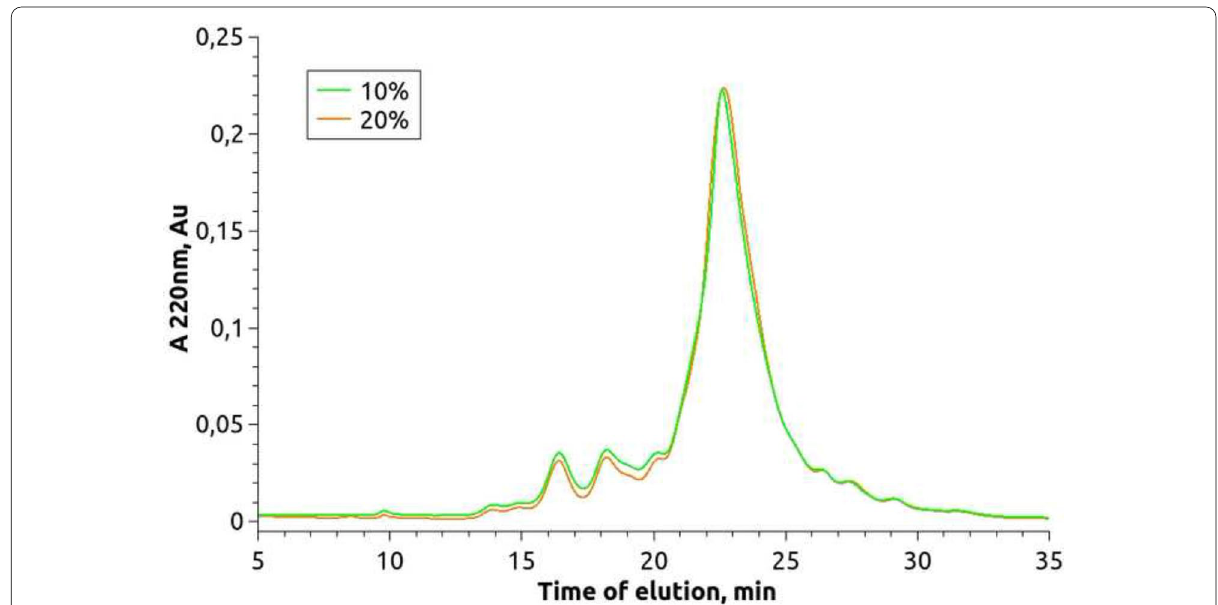
Fig. 5 Chromatogram of 10% and 20% SPI hydrolysate. The SPI hydrolysates were obtained by enzymatic hydrolysis of SPI isolate Shansong 90 using commercial enzyme Protosubtilin G3x with protease activity 11.9 Units/g of SPI at 50 ◦ C with no buffering